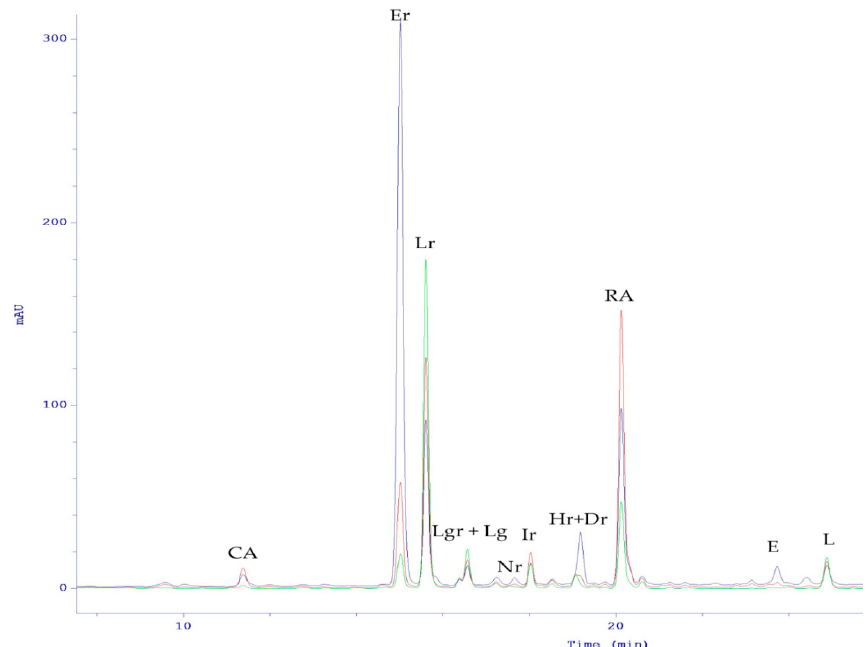
Figure 6. Typical HPLC chromatograms of peppermint tincture at 280 (blue line), 320 (red line), and 360 nm (green line). CA, caffeic acid; Er, eriocitrin; Lr, luteolin rutinoside; Lgr, luteolin glucuronide; Lg, luteolin glucoside; Nr, narirutin; Ir, isorhoifolin; Hr, hesperidin; Dr, diosmin; RA, rosmarinic acid; E, eriodictyol; L, luteolin.